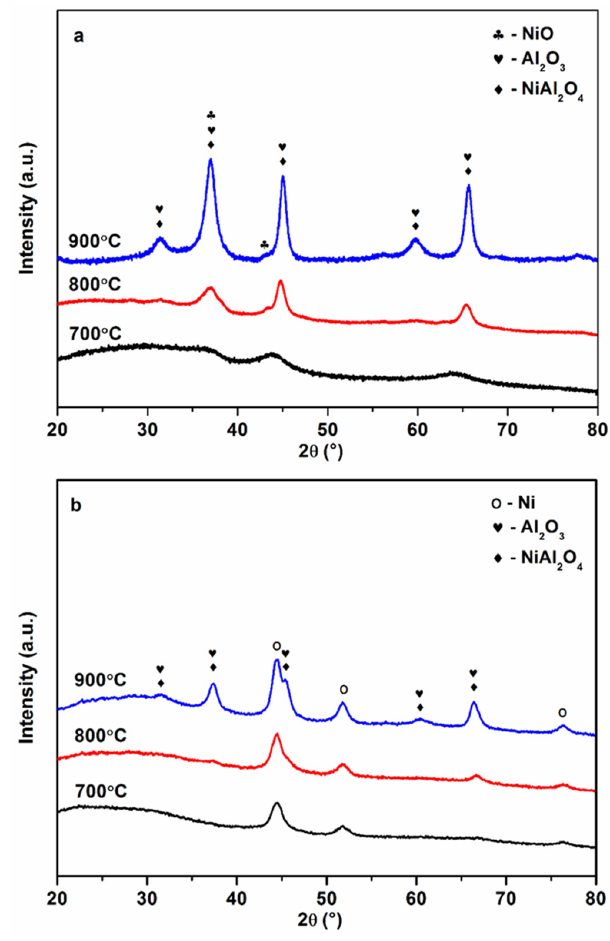
Figure 11. XRD patterns of the catalysts with different calcination temperatures: ( a ) Before reduction; ( b ) after reduction at 750 ◦ C for 1 h. ( b ) after reduction at 750 °C for 1 h.